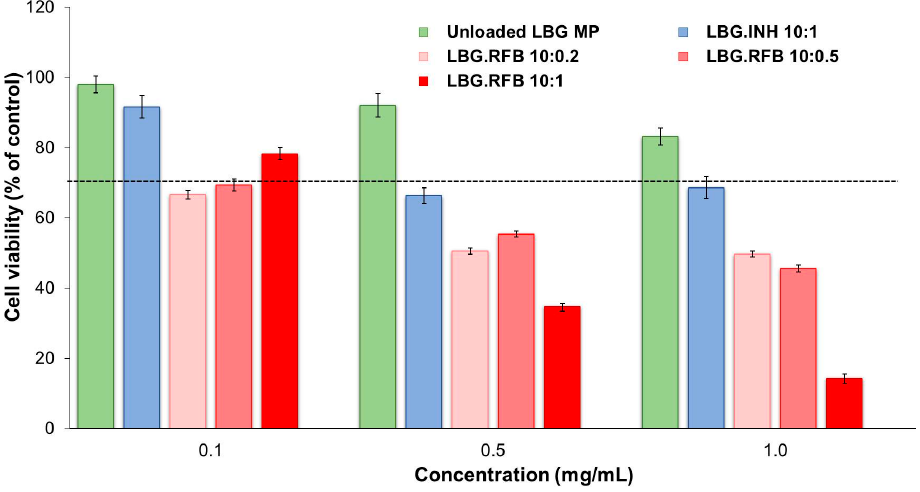
Figure 6. A549 cell viabilities after 24 h of exposure to LBG-based microparticle formulations. Results are expressed as mean ± SEM ( n = 3, six replicates per experiment at each concentration). Dashed line represents 70% cell viability (INH: isoniazid, LBG: locust bean gum, RFB: rifabutin).